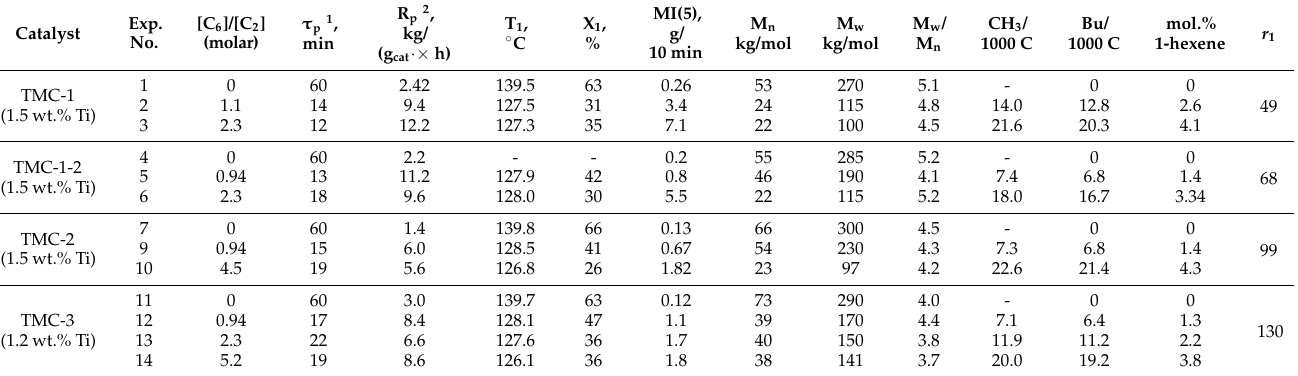
Table 2. Data on the copolymerization of ethylene with 1-hexene over Ti-Mg catalysts containing titanium compounds in different oxidation states as the active